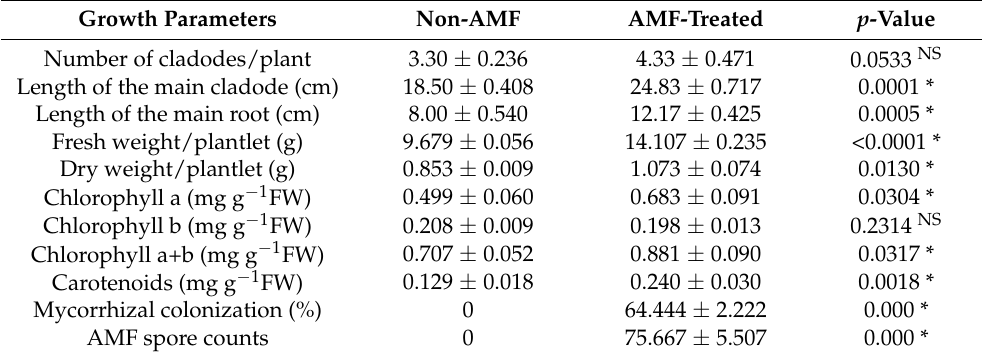
Figure 3. In vitro regeneration and development of H. polyrhizus axillary cladode. ( a ) Distribution and distance among areoles ( ≅ 3 mm; arrow) along the in vitro cladode; ( b ) transverse section of in vitro cladode showing five sides; ( c ; arrow) axillary cladode regeneration at the explant proximal areoles in gelled culture; ( d ) regeneration of both axillary cladode and secondary axillary cladode (arrow) from the whole areoles in air-lift bioreactor cultures; ( e , f ) reduction in number of cladode sides (arrow showing dead end) from 5 to 3 in mature plants. Table 2. Vegetative growth characteristics, leaf pigments, total colonization percentage and AMF spore count of H. polyrhizus in response to arbuscular mycorrhizal fungi after 8 weeks of